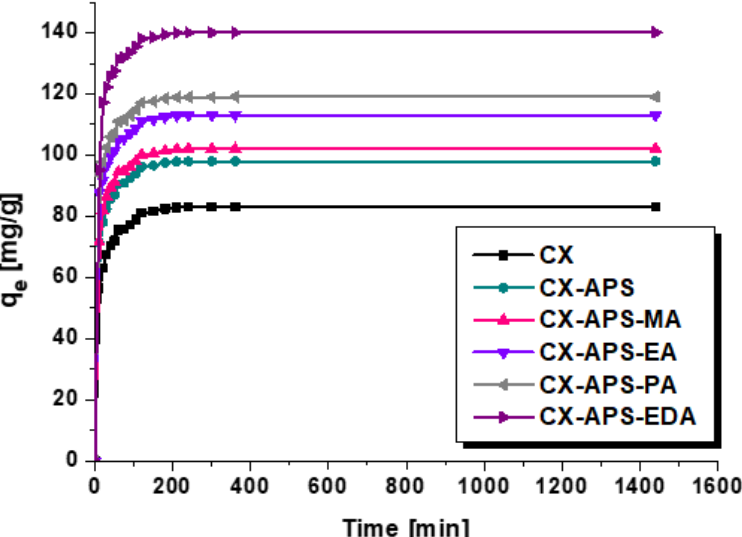
Figure 5. Effect of contact time on the sorption capacity of carbon xerogels (adsorbent mass, 20 mg; initial dye solution concentration, 150 mg/L; volume of dye solution, 50 mL, pH = 4; temperature, 22 ± 1 °C).